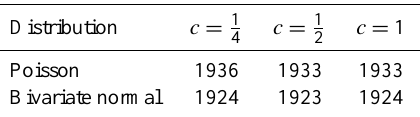
Table 3. Atlantic tropical storm data from 1851 to 2008 are used to detect any mean change in tropical storm characteristics. Here c is the magnitude representing the number of standard deviation from the mean. The result shows that the number of tropical storm had a significant increase around 1933–1936, and strength of the tropical storm increased around 1923–1924.